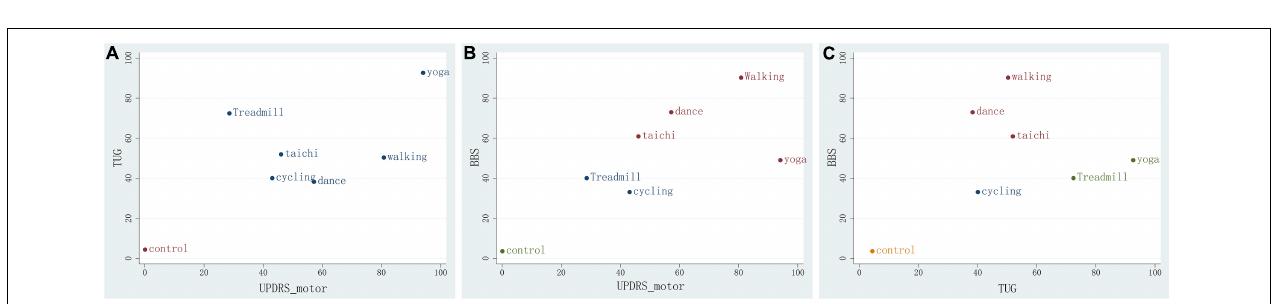
FIGURE 4 | Dose response of yoga using meta-regression and SUCRA on UPDRS-motor outcome. (A–D) The potential optimal time of yoga per session in UPDRS motor scale; (E–H) The potential optimal frequency of yoga each week in UPDRS motor outcome. (A,E) Dose-response curve for yoga using metaregression. (B–D,F–H) Dose response of yoga based on the rank probability and mean rank. The greater the SUCRA value is, the better the rank.